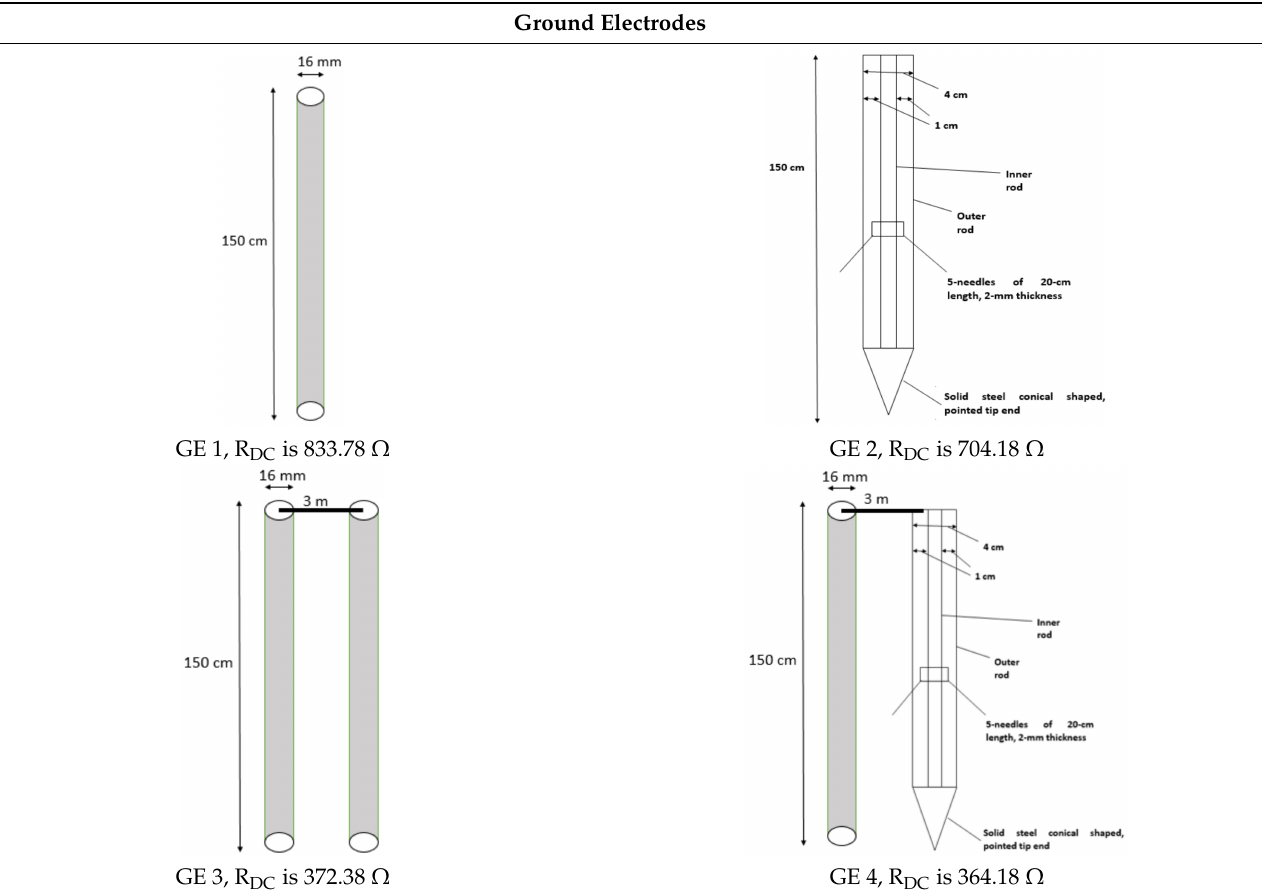
Figure 1. Impulse test arrangement on practical ground electrodes. Table 1. Various ground electrodes and measured R DC